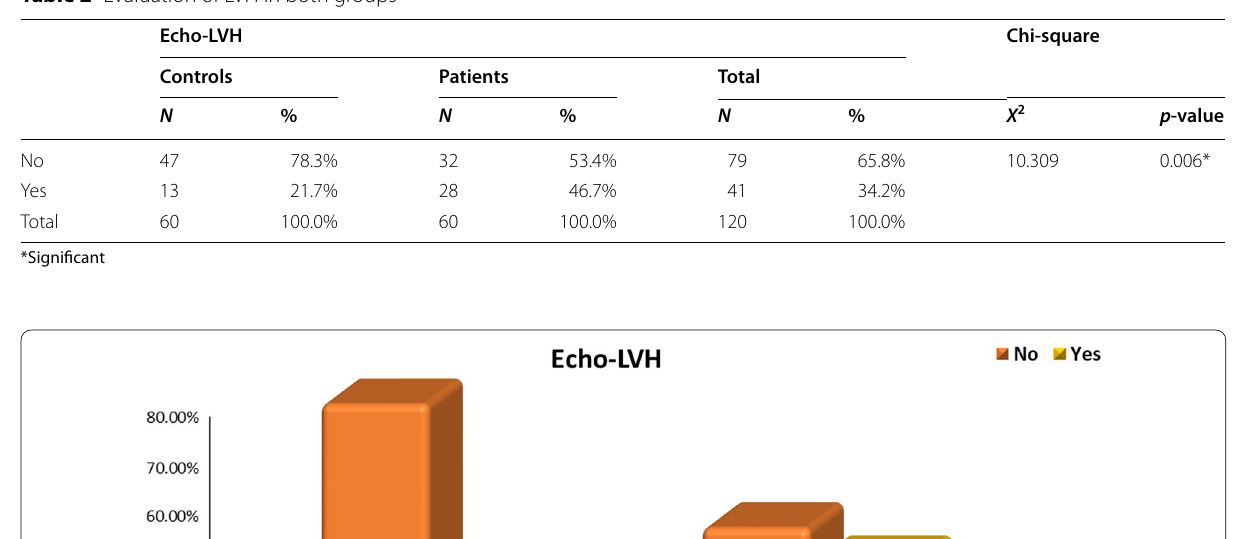
Table 2 Evaluation of LVH in both groups